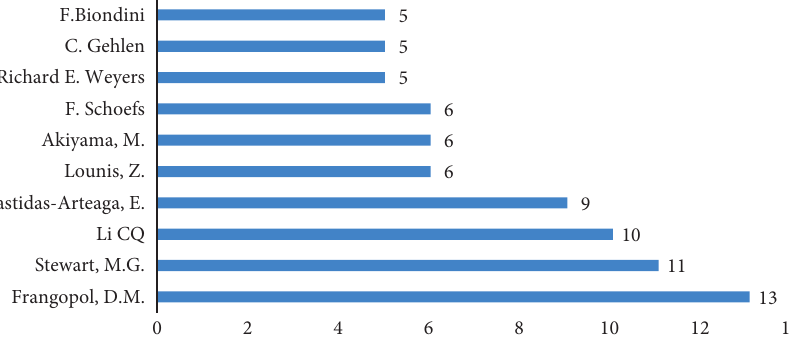
Figure 5: The most prolific authors with at least 5 publications in databases.